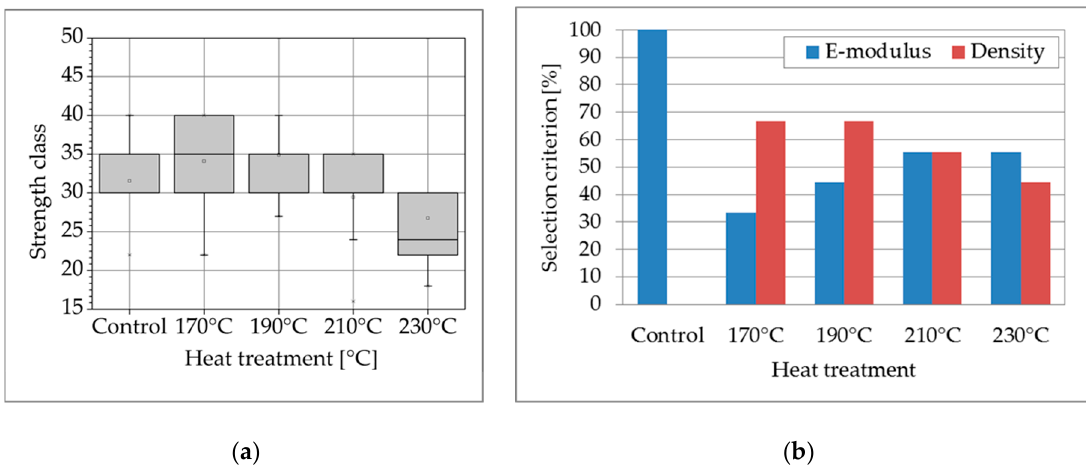
Figure 4. ( a ) Strength class distribution of heat-treated structural timber; ( b ) the decision making selection criteria for strength grading of heat-treated structural timber.